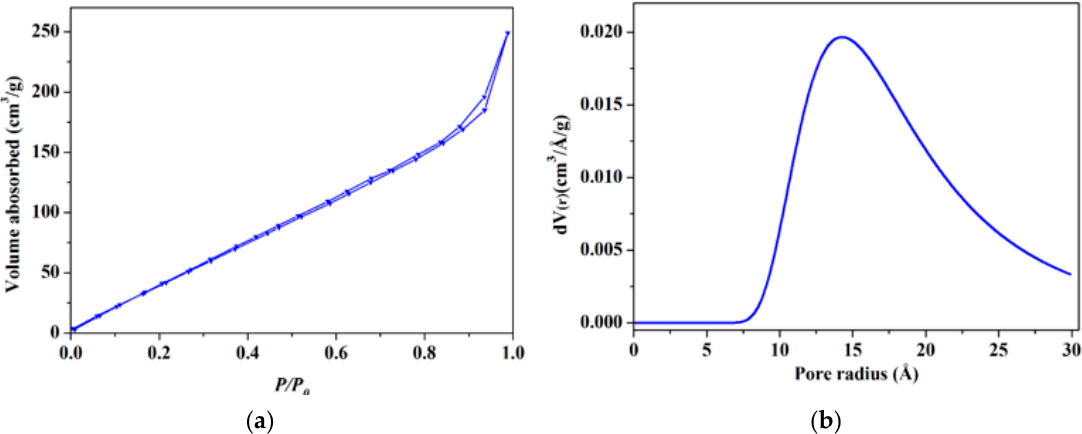
Figure 4. ( a ) Nitrogen adsorption/desorption isotherm and ( b ) DA pore size distribution plot of MIONPs.